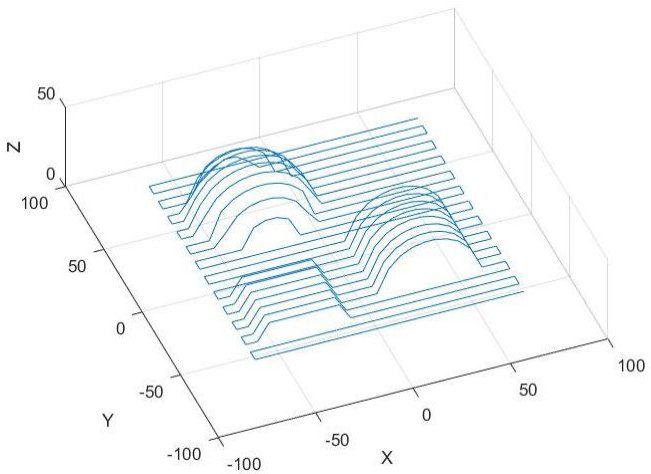
Figure 9. Path generated by the point cloud slicing technology.